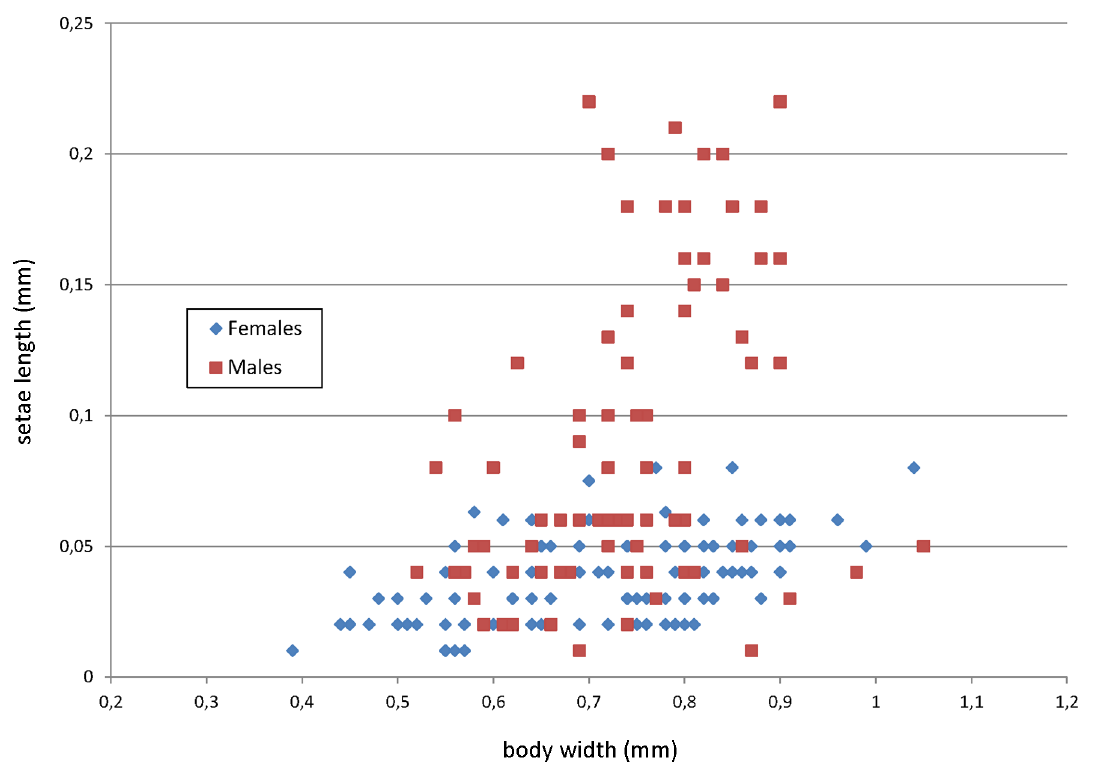
Fig. 4. Siphonophora setaepromissa sp. nov., relationship between body width and setae length in males and